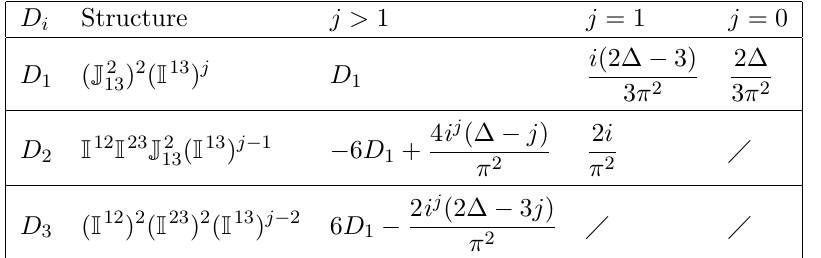
OTO when O has spin ( 1 h i